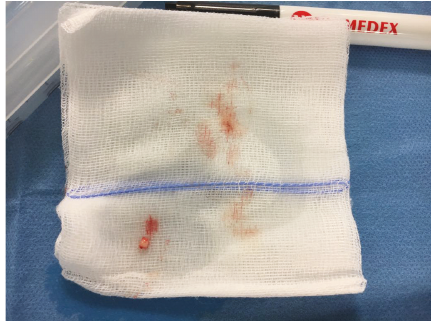
Figure 3: The harvested skin punch biopsy.